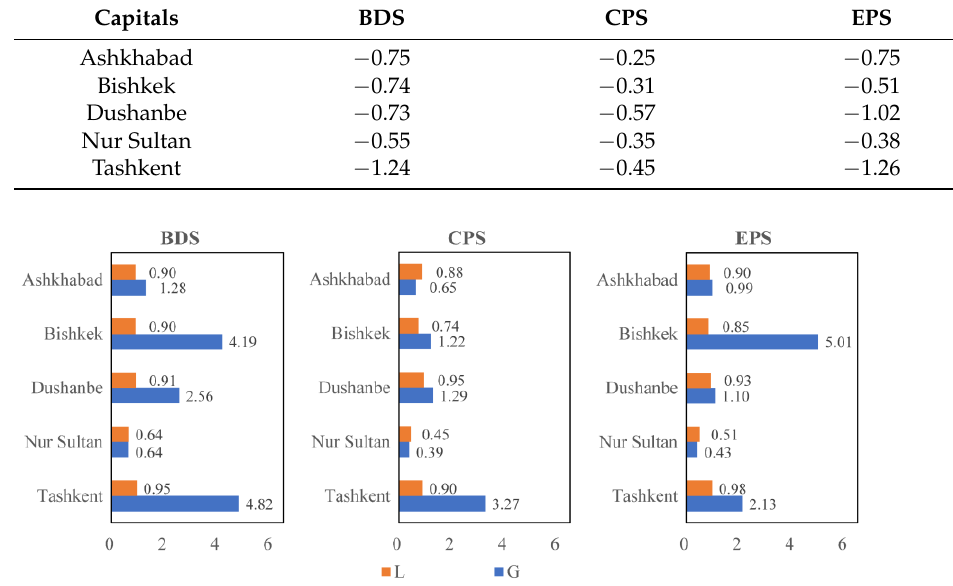
Figure 4. The comparisons between carbon storage loss resulting from urban expansion and the total carbon storage loss/growth. Note: L and G refer to the ratio of carbon storage loss induced by urban expansion to the total carbon storage loss/growth, respectively.